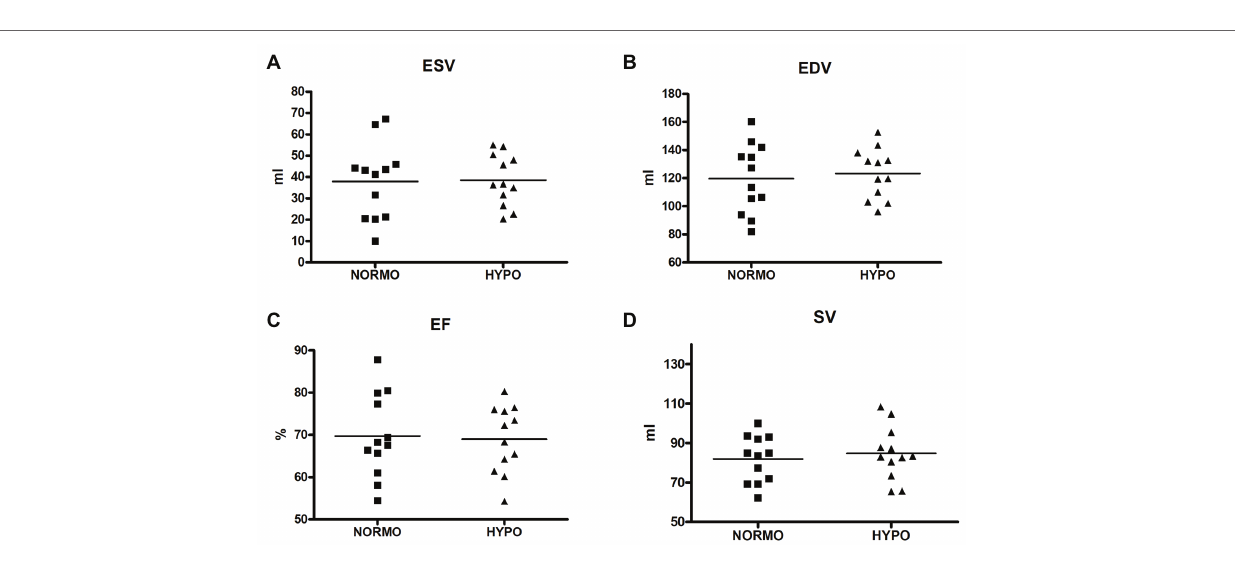
FIGURE 2 | Scatter plot graphs of levels of end-systolic volume (ESV, panel A ), end-diastolic volume (EDV, panel B ), ejection fraction (EF, panel C ), and stroke volume (SV, panel D ) during the recovery from sessions of exercise in normoxia (NORMO) and in normobaric hypoxia with a FiO 2 of 13.5% (HYPO). N =